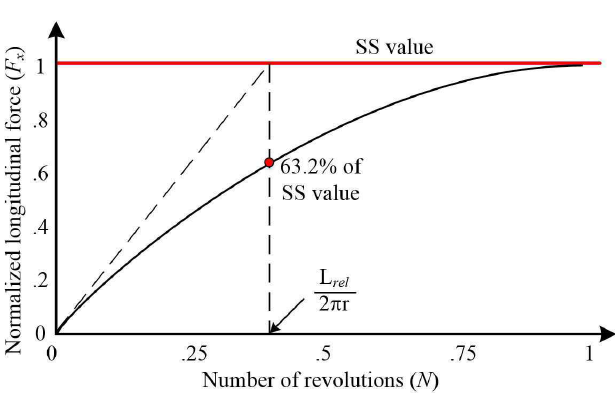
Fig. 12. Longitudinal force build-up: the concept of tire relaxation length and time constant [37].